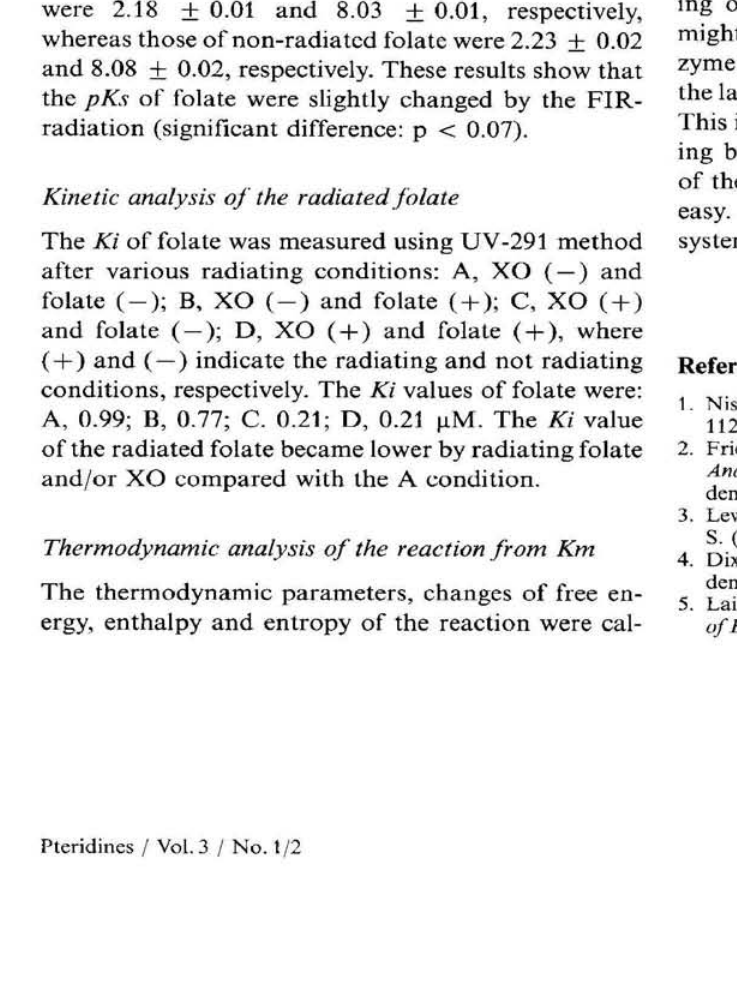
Figure 1. Effect of FIR-radiation on xanthine oxidase reaction 91% (UV-291 method), respectively, of those with non-radiated enzyme. The activity remained during at least 2-day storage at 4 °C after stopping the ra-